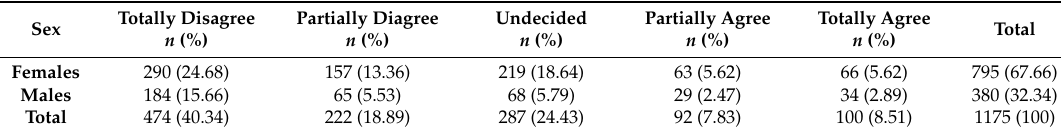
Table 5. Association of students if they are planning to work in a private equity or insurance-led dental center.